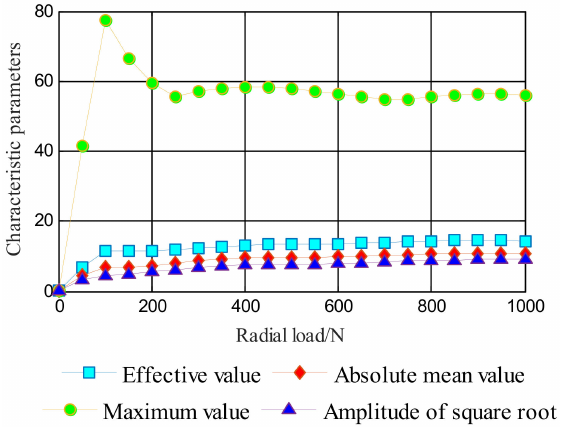
Figure 24. Influence of the radial load on dimensional